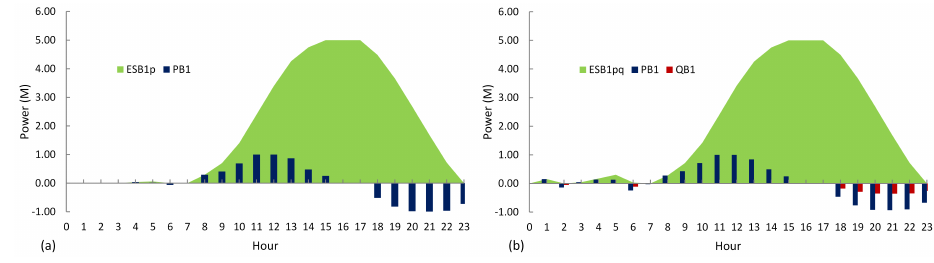
Figure 7. Power management for one BESS unit: ( a ) active power; ( b ) active and reactive